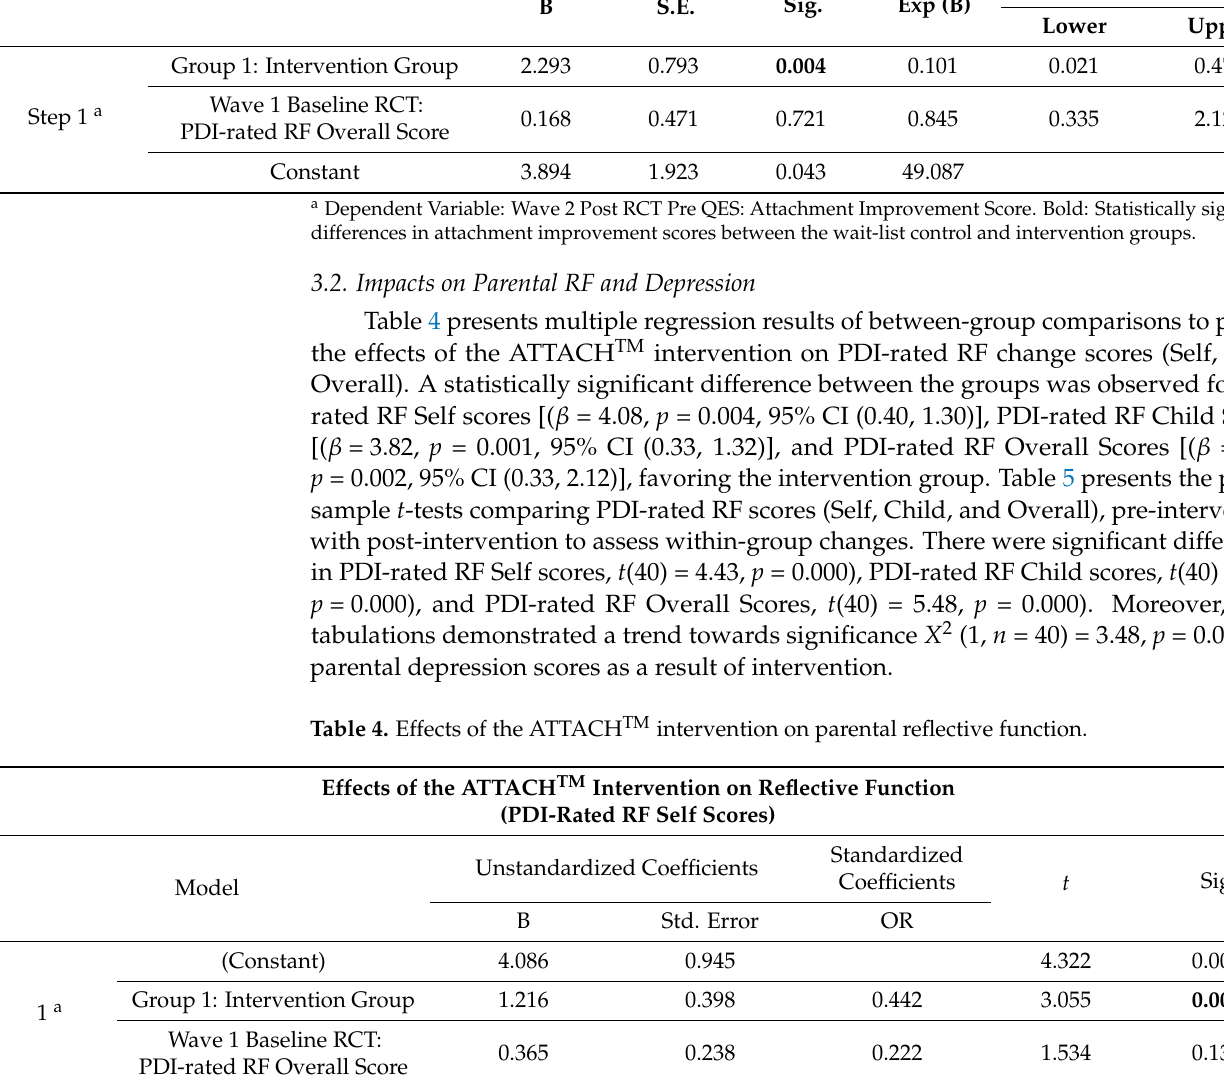
Table 3. Effects of the ATTACH TM intervention on parent–child attachment security. [Attachment Improvement scores classified as improved/remained secure (1) or insecure/not improved (0)]. B S.E. Sig. Exp (B)